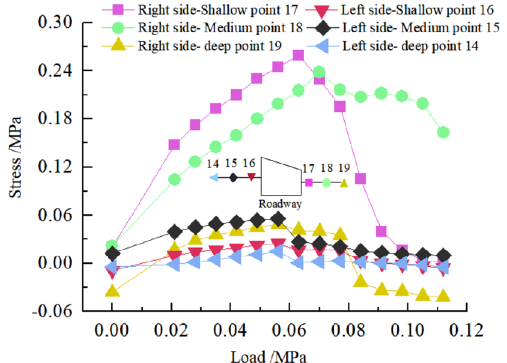
Figure 15. Curve of stress on two sides of roadway with load.